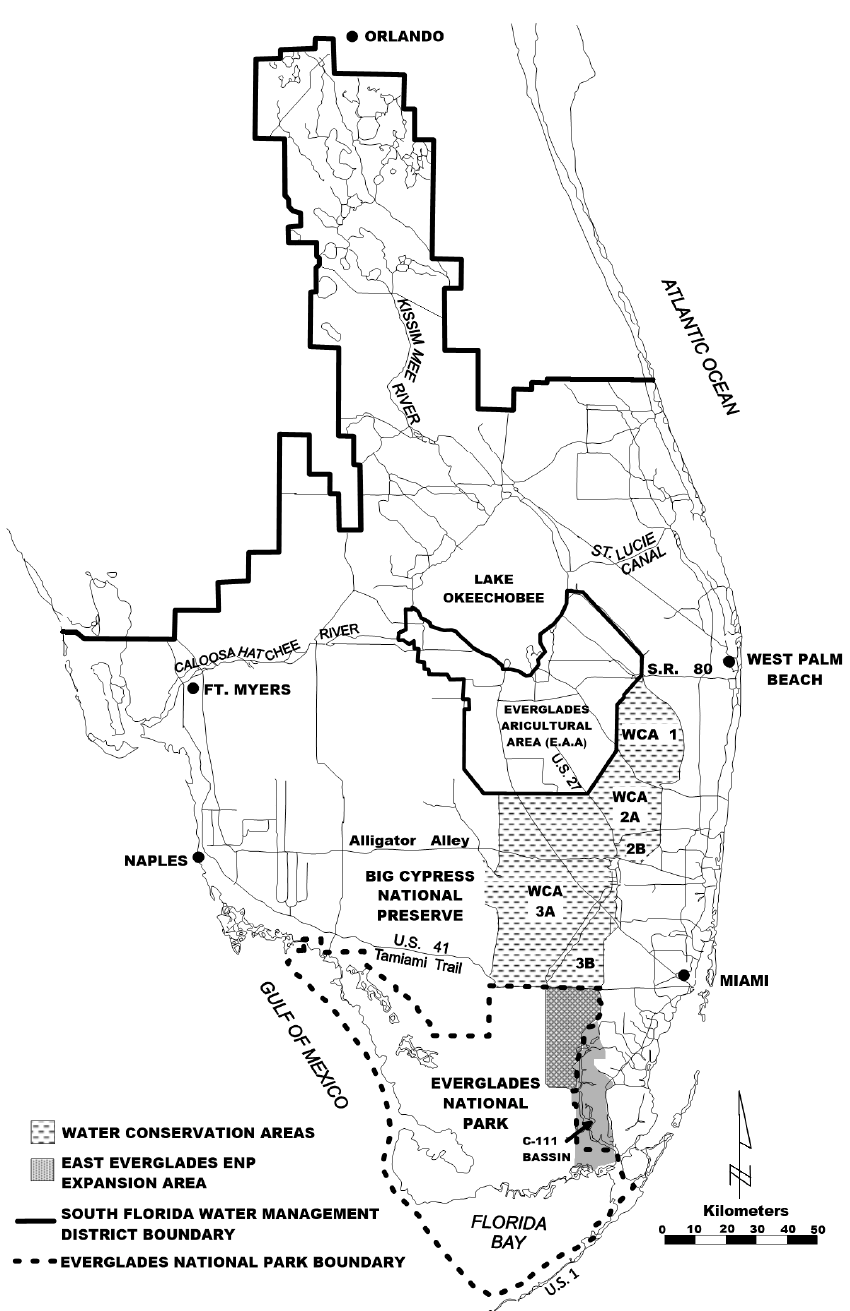
Figure 1. Lake Okeechobee and its associated watershed.